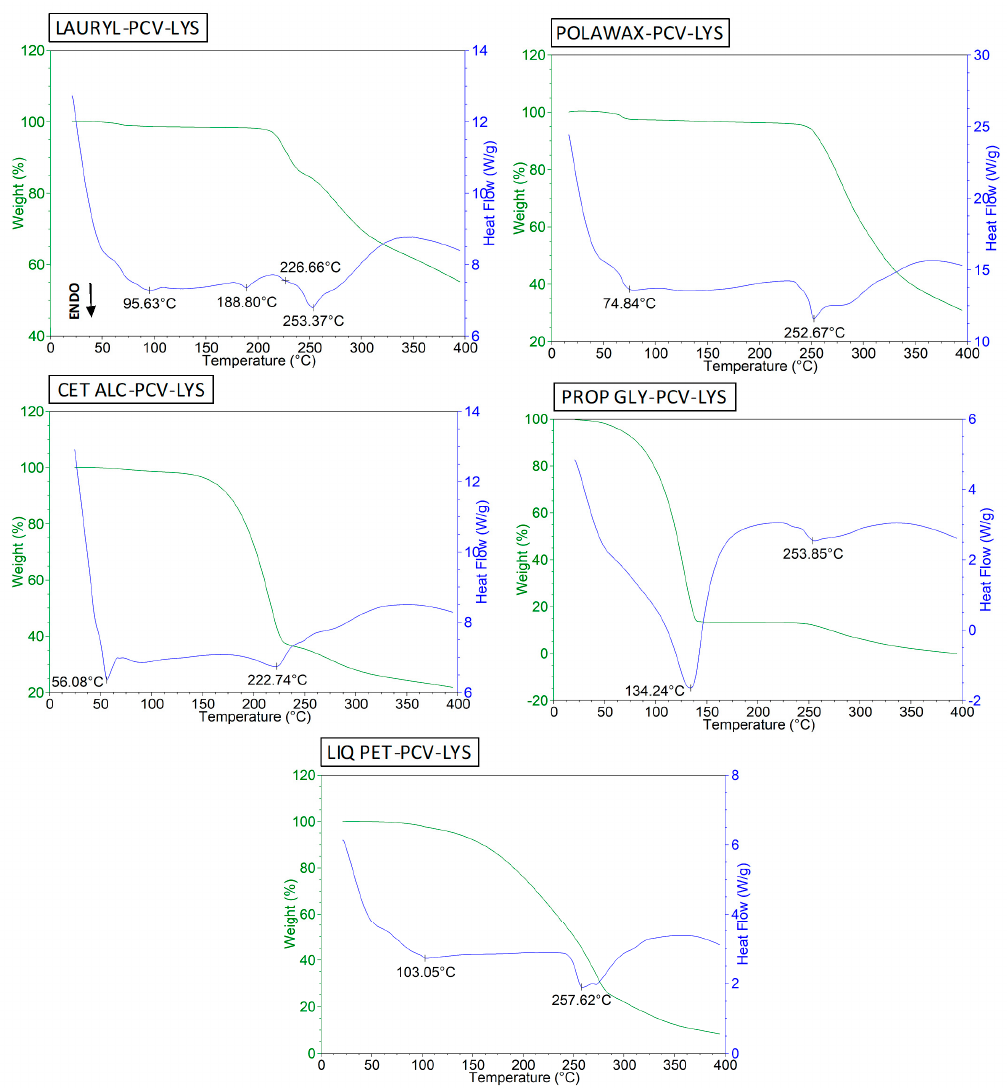
Figure 7. DSC curves for LAURYL-PCV-LYS, POLAWAX-PCV-LYS, CET ALC-PCV-LYS, PROP GLY-PCV-LYS and LIQ PET-PCV-LYS.